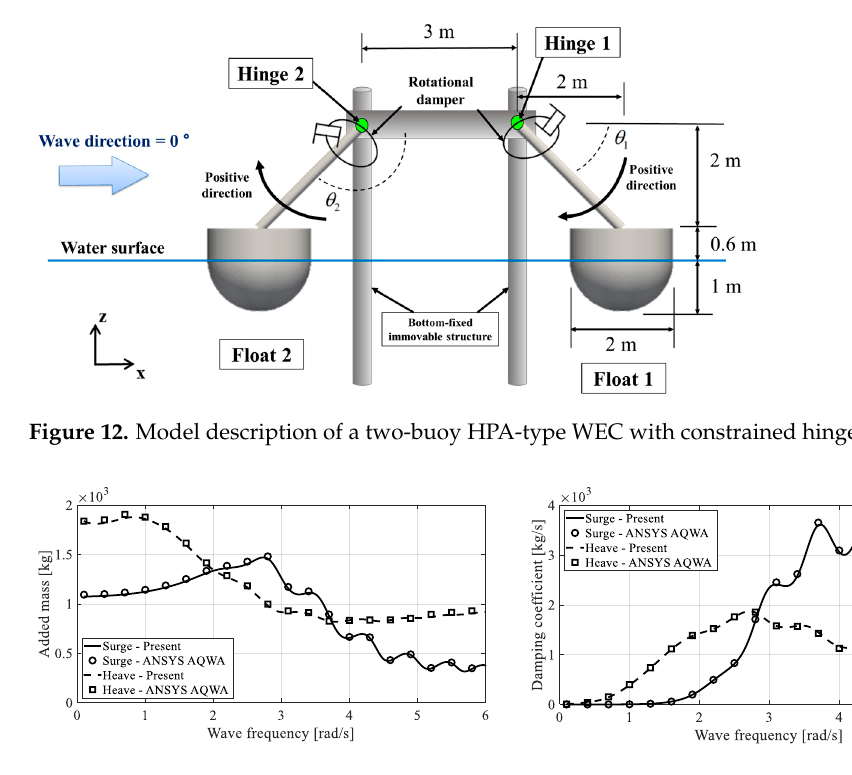
Figure 14. Comparison of the pitch RAO according to the distance between hinge points at Chilbaldo (H = 1.26 m, T = 5.46 s). First, when the wave period has a constant value for each location, the effects of a change in the wave height were compared. Figure 15 represents the pitch RAO assessed through linear and weakly nonlinear analysis according to the wave steepness when a wave with the period shown in Table 2 acts on each location. In the case of linear analysis, when the wave steepness was greater than 0.0455 (1/22), the results were inaccurate and were excluded from the comparison. The result for each location was generally similar in magnitude and trend regardless of the location because the environmental conditions were similar. The linear and weakly nonlinear analysis results showed a difference of approximately 5 % when the wave steepness was close to zero. On the other hand, the difference in the magnitude and trend of pitch RAO between the two methods increased significantly as the incident wave steepness increased. This means that time-domain analysis considering the nonlinear components of the external force must be performed for the design of Wavester-type WEC. The magnitude of the pitch RAO of the float varies with the wave steepness, which can be attributed to the change in the magnitude of the moment acting on the center of rotation of the float. When the wave steepness was between 0.02 (1/50) and 0.0455, the pitch RAO of Float 1 (rear body) was greater than that of Float 2 (front body). Because the wave steepness shown in Table 2 falls within this range, it can be expected that power production will be larger for Float 1 (rear body) in real sea conditions.